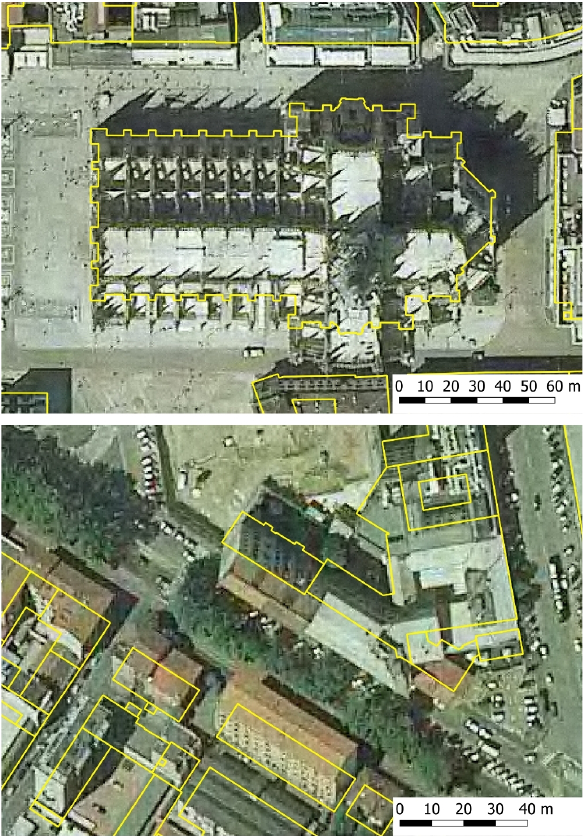
Figure 6. Visual comparisons between the orthophoto and the official building